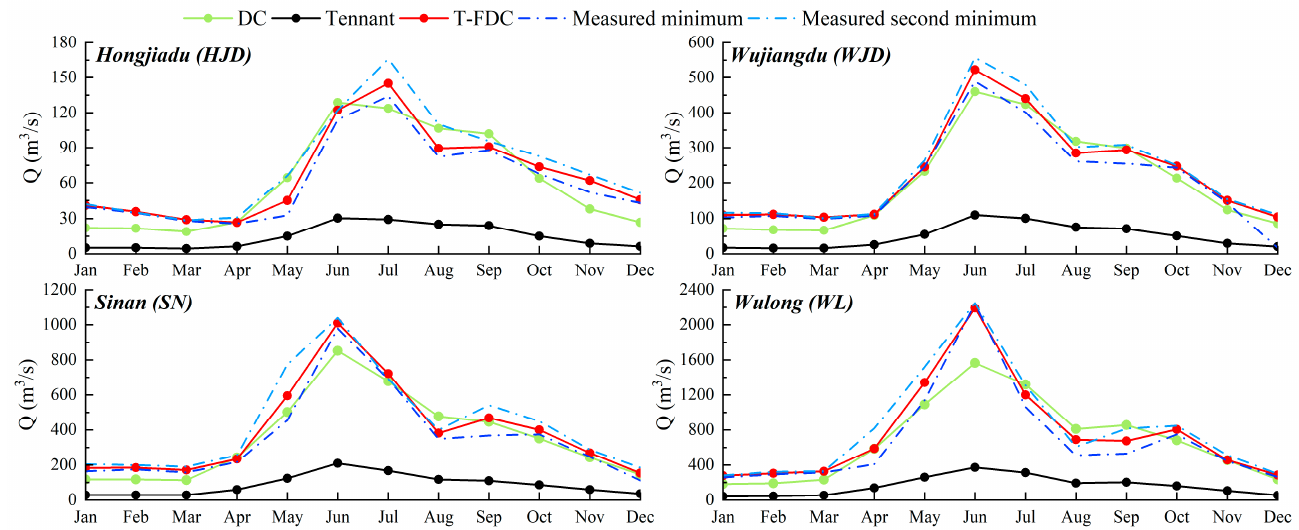
Figure 5. Basic environmental flow calculated by various methods and measured small flow.